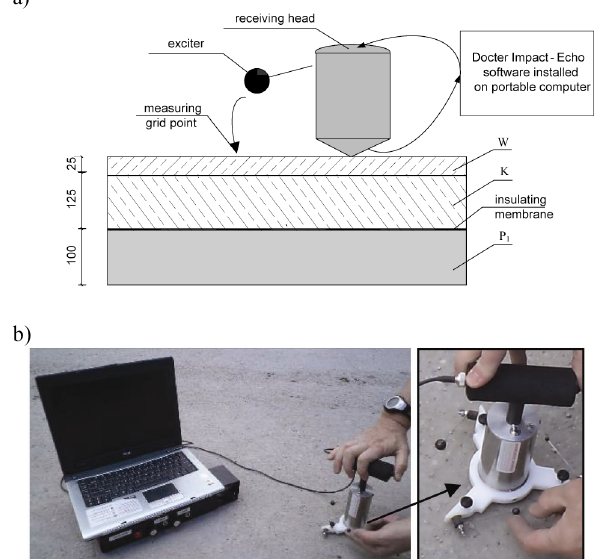
Fig. 6. Schematic of impact-echo test rig (a), and actual testing (b)